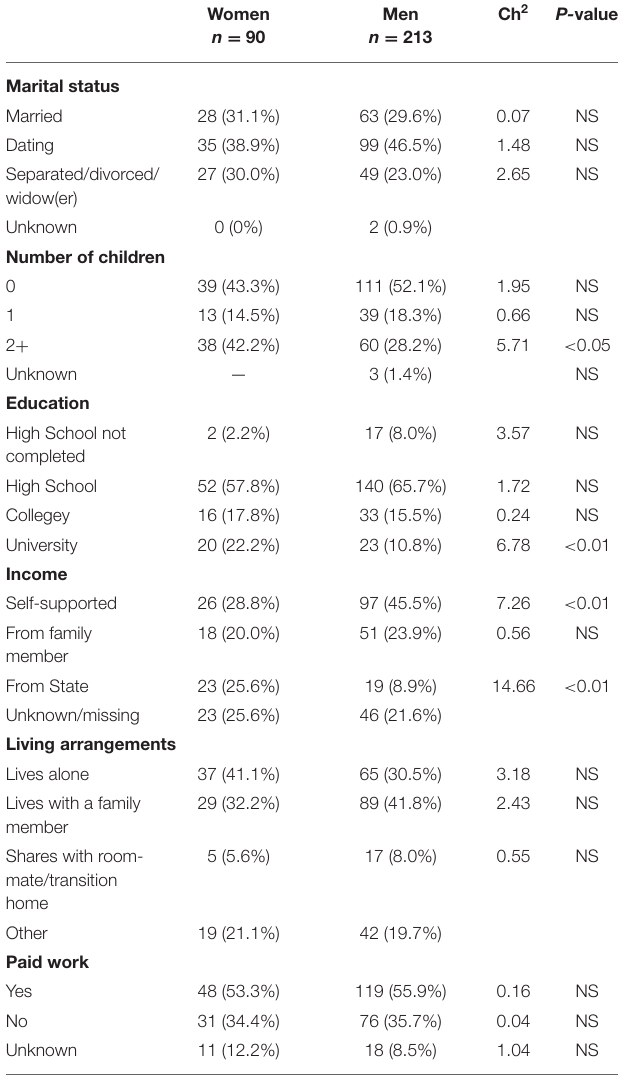
TABLE 1 | Socio demographic